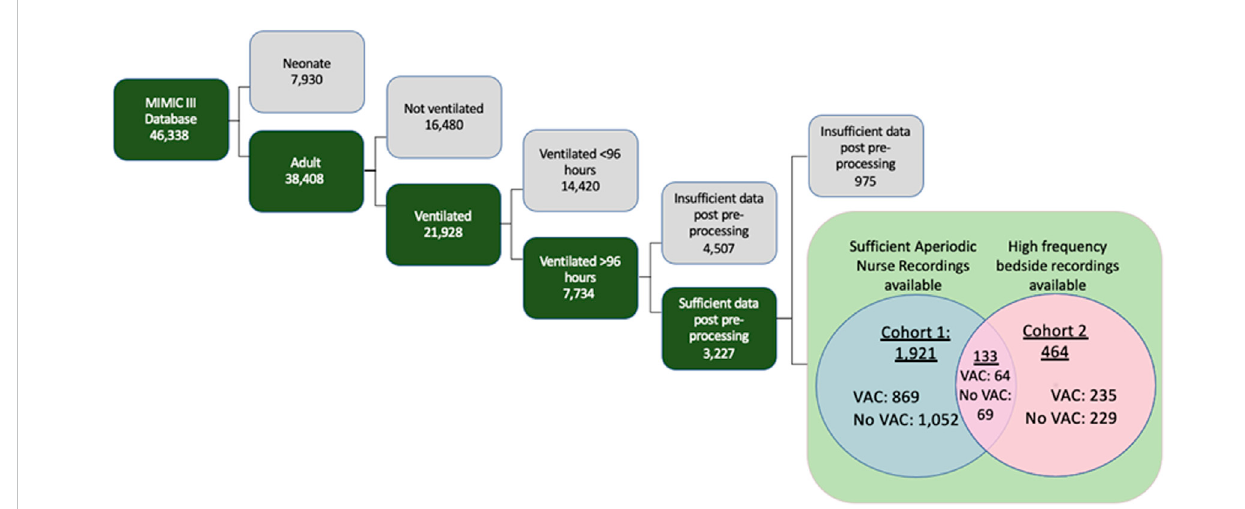
FIGURE 1 Inclusion criteria for MIMIC-III database to arrive at anticipated patient Cohorts One and Two, both of which were composed of patients who had enough data points for automatic statistical feature extraction methods. Cohort One consists of patients with aperiodic data recorded by nurses and clinicians, and Cohort Two consists of patients with high frequency waveform